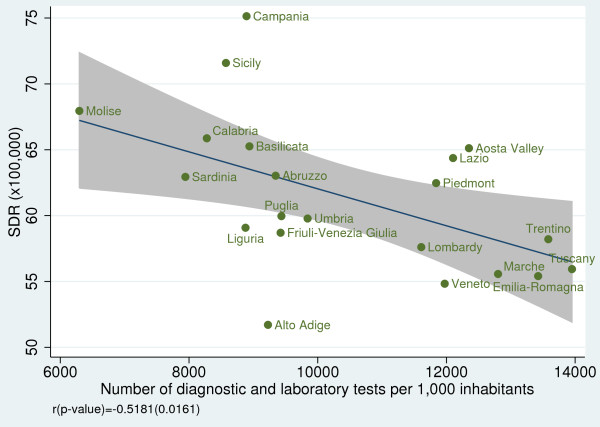
Amenable mortality vs. number of diagnostic and laboratory tests per 1,000 inhabitants for the year 2008. Data source: Ministero della Salute – Sistema Informativo Sanitario 2008 [17].